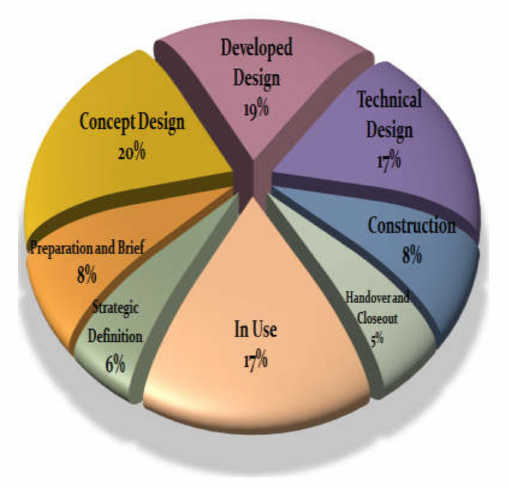
Figure 7. Lifecycle stage